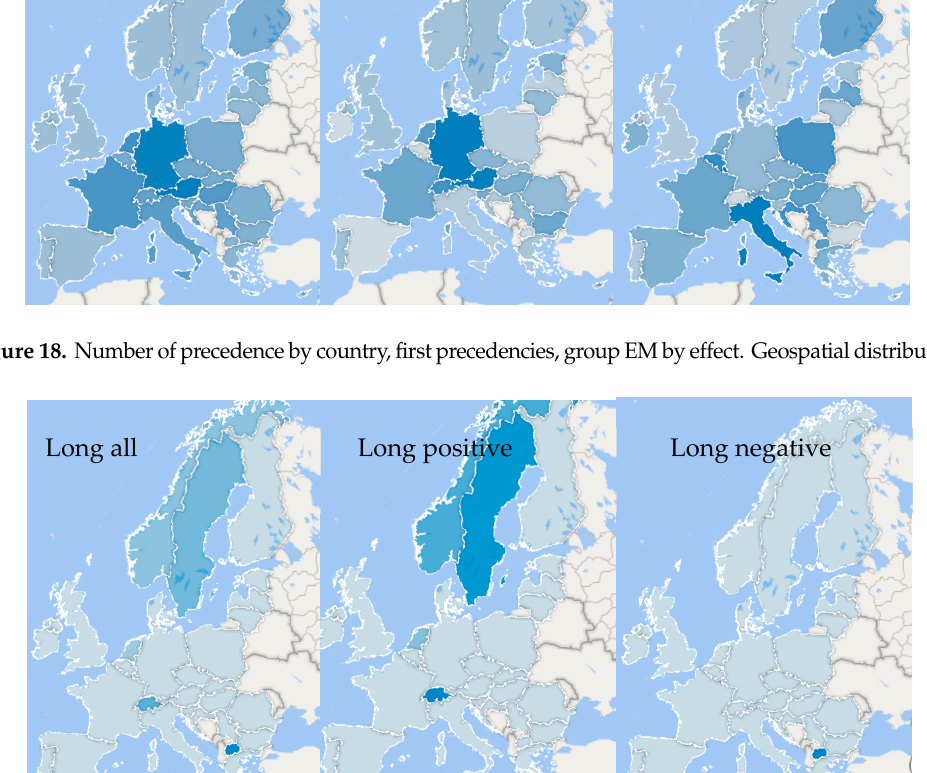
Figure 21. Number of precedence by country, first and long precedence group RD by effect. Geospatial distribution. 3.3.5. Group Soc The group of Soc factors, unlike RD, has only negative factors, due to the fact that there are factors related to material deprivation and the risk of poverty in the group. The figures on Figure 22 show that Austria (164, max) has the highest first precedence, France (153) and the Netherlands also have a high number. High values in these countries cause the average to be higher than the median (52.8 → 42.5). Above-average values are also reported by Czechia and Slovakia, Czechia also has the longest precedents (13, max). Long precedents are found in only five countries, Czechia, Switzerland (12), Netherlands (5), France (3), and Luxembourg (1). Show by map is in the Figure 23. First